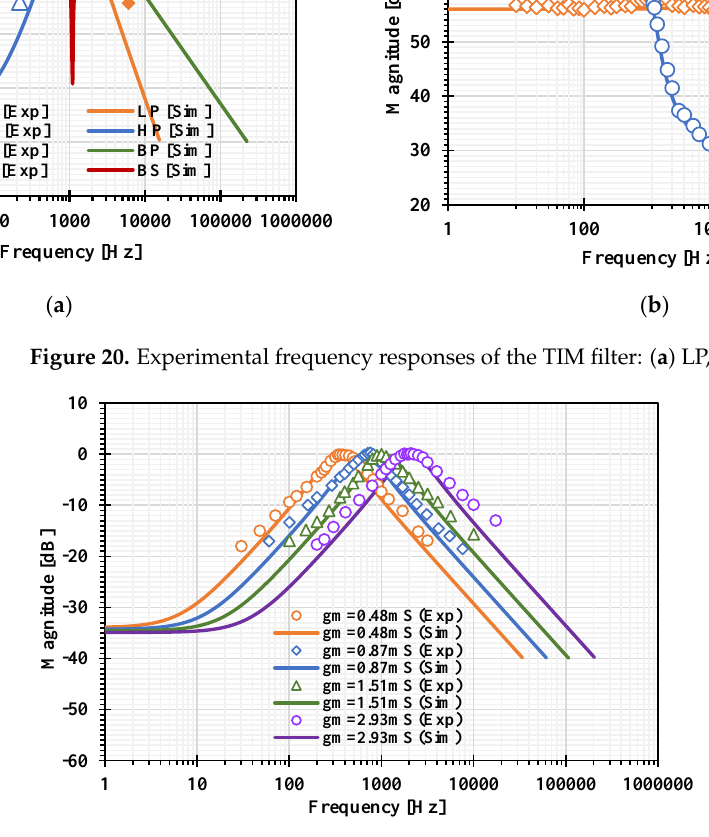
Figure 21. The experimental frequency responses of the BP response of the VM filter with different transconductances.